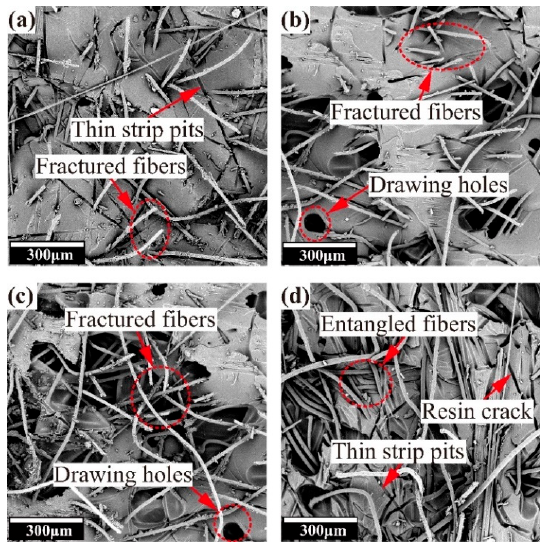
Figure 4. SEM images of delaminated surfaces of ( a ) 10 PI-toughened composite, ( b ) 20 PI-toughened